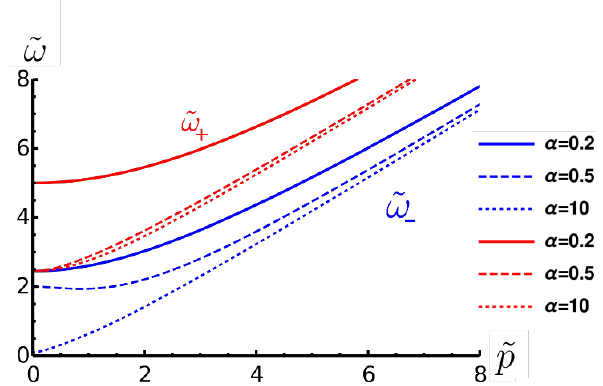
Figure 1 . The dispersion relations of the two branches of perturbative (cid:13)uctuations for the quartic potential ( s = 2), with di(cid:11)erent values of the dimensionless coupling (cid:11)